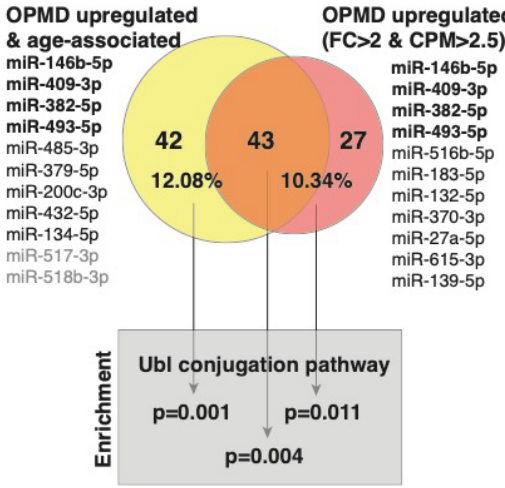
Figure 4. A graphical summary of predicted targets analysis. The OPMD upregulated miRNAs and those that are also age-associated are listed. The OPMD upregulated miRNAs inclusion criteria: average fold-change (FC) > 2 and average CPM > 2.5. In bold are the four miRNAs that are common between the two conditions. The miRNAs without predicted gene targets are in grey. Venn diagram shows the overlap between the number of OPMD-downregulated predicted targets to the OPMD upregulated miRNAs that are age-associated (yellow) and the OPMD upregulated miRNAs ( red ). The percentage of predicted targets from the OPMD downregulated gene list is depicted.